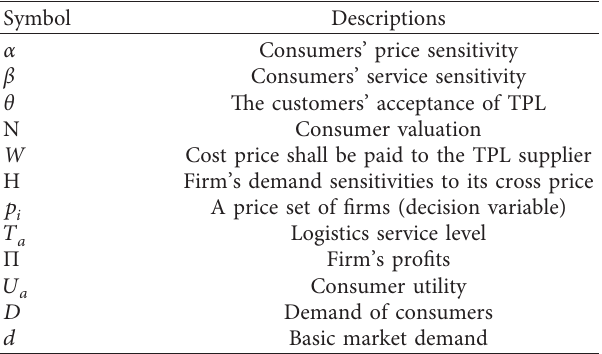
Table 1: Notations for the